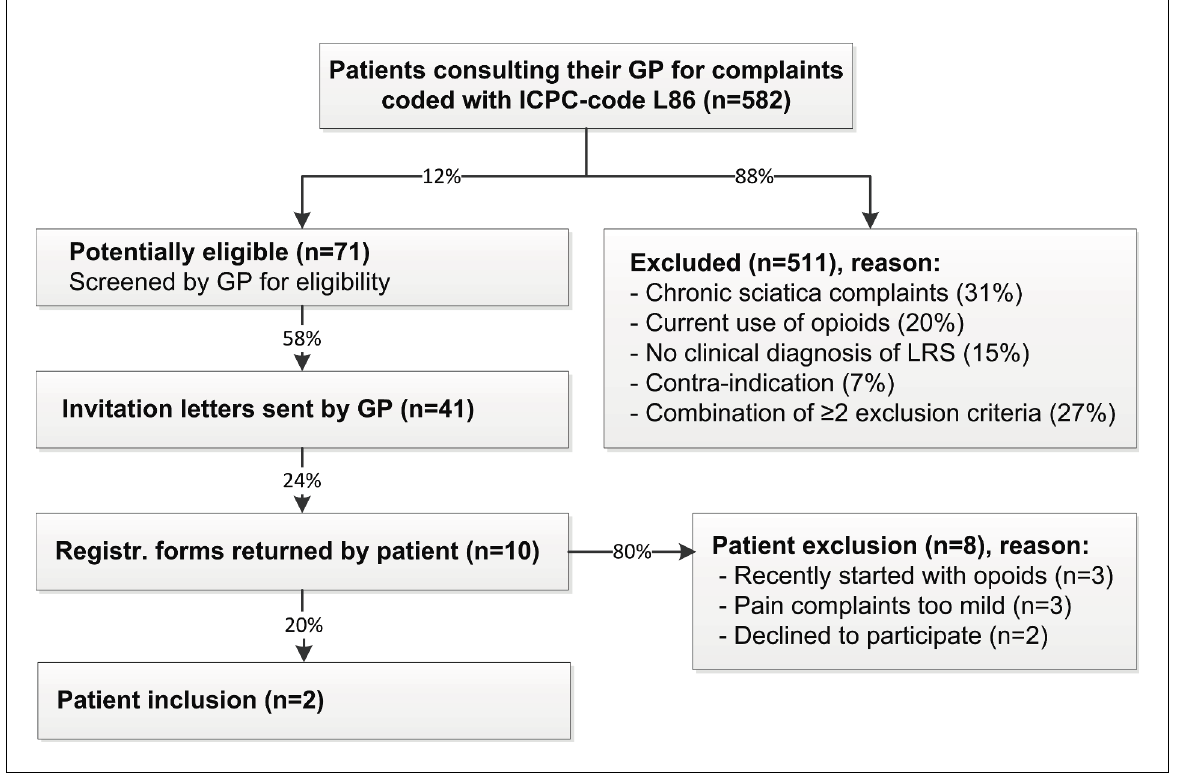
Figure 2. Systematic screening of GP information systems during a 3.5-month period. LRS = lumbosacral radicular syndrome.